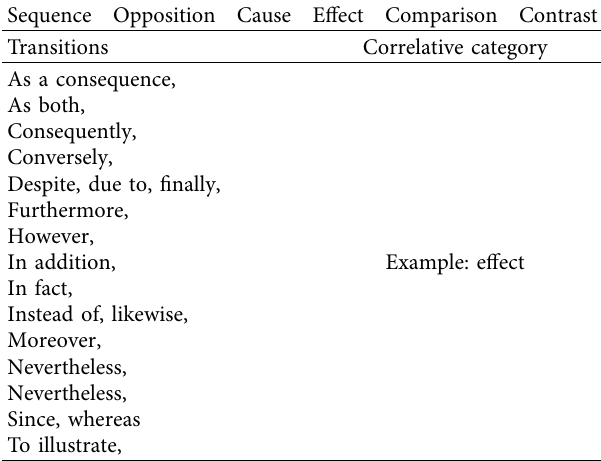
Table 3: A sample item of transition word test.